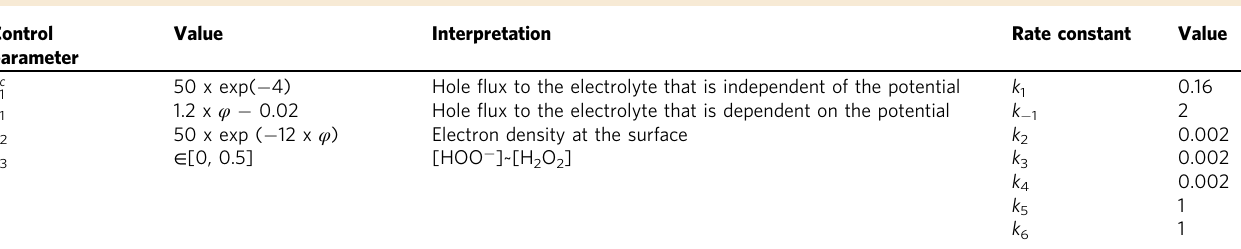
Table 1 Summary of dimensionless control parameters and the rate constants used for the numerical computation of the results presented in Fig.